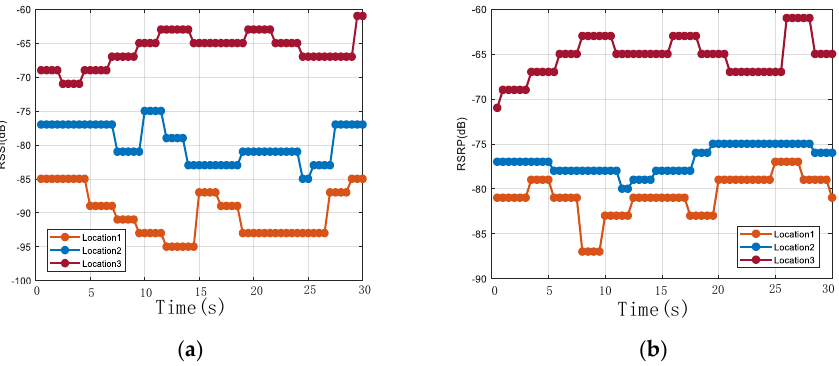
Figure 1. Signal fluctuation of ( a ) received signal strength indicators (RSSIs) and ( b ) reference signal receiving powers (RSRPs) at three fixed locations over time. Each graph contains 60 samples.